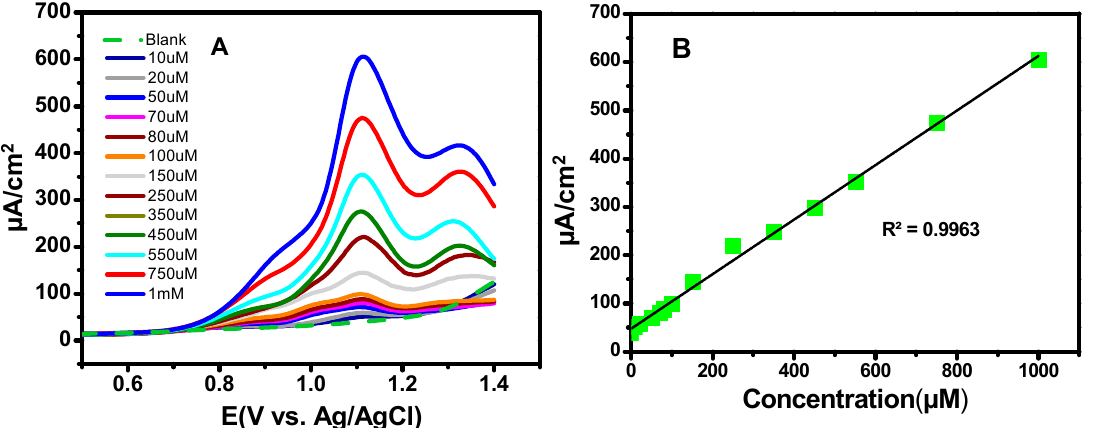
Figure 6. ( A) DPV responses at di ff erent naproxen concentrations for the GO / GCE using DPV. ( B ) Calibration curve exhibits a linear response in current density as the concentration increased from 10 µ M to 1 mM.